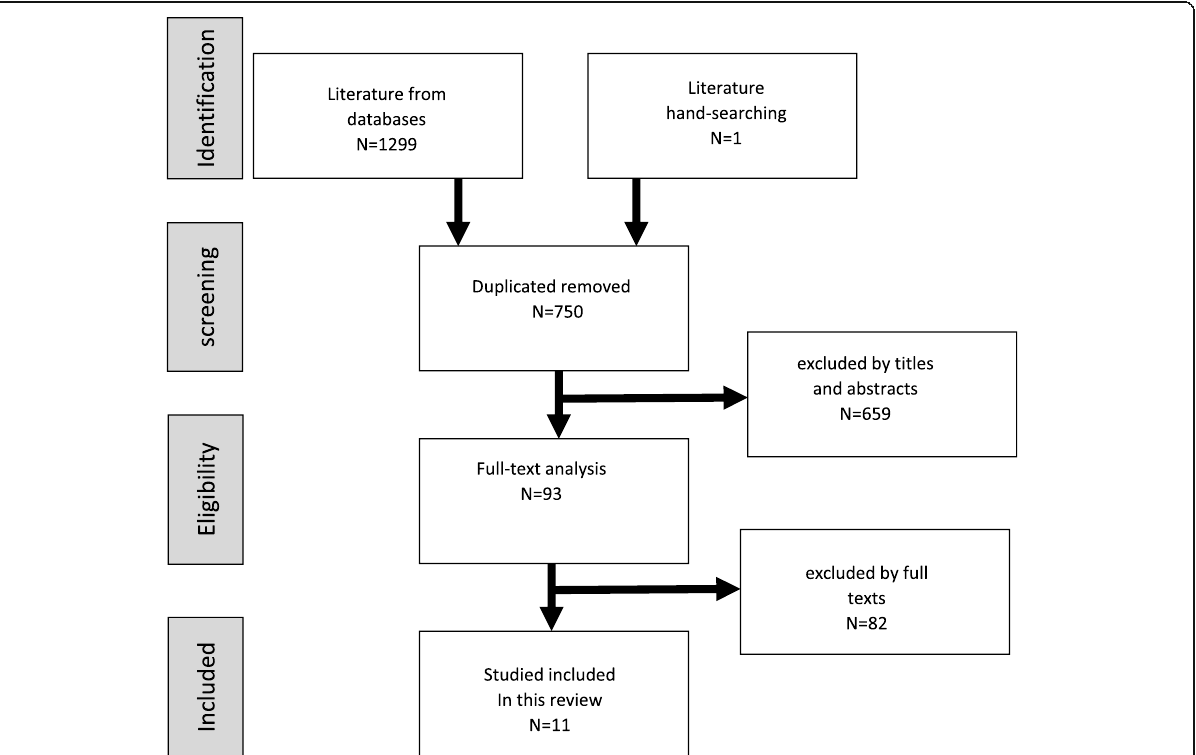
Fig. 1 MOOSE (the guidelines of Meta-Analysis of Observational Studies in Epidemiology) program for